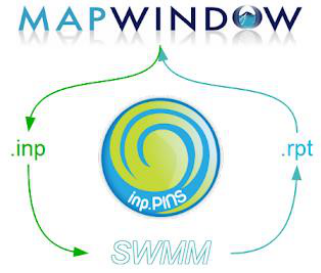
Figure 6: working diagram of inpPINS